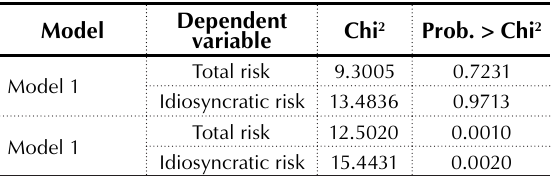
Table 5. Results of heteroscedasticity test